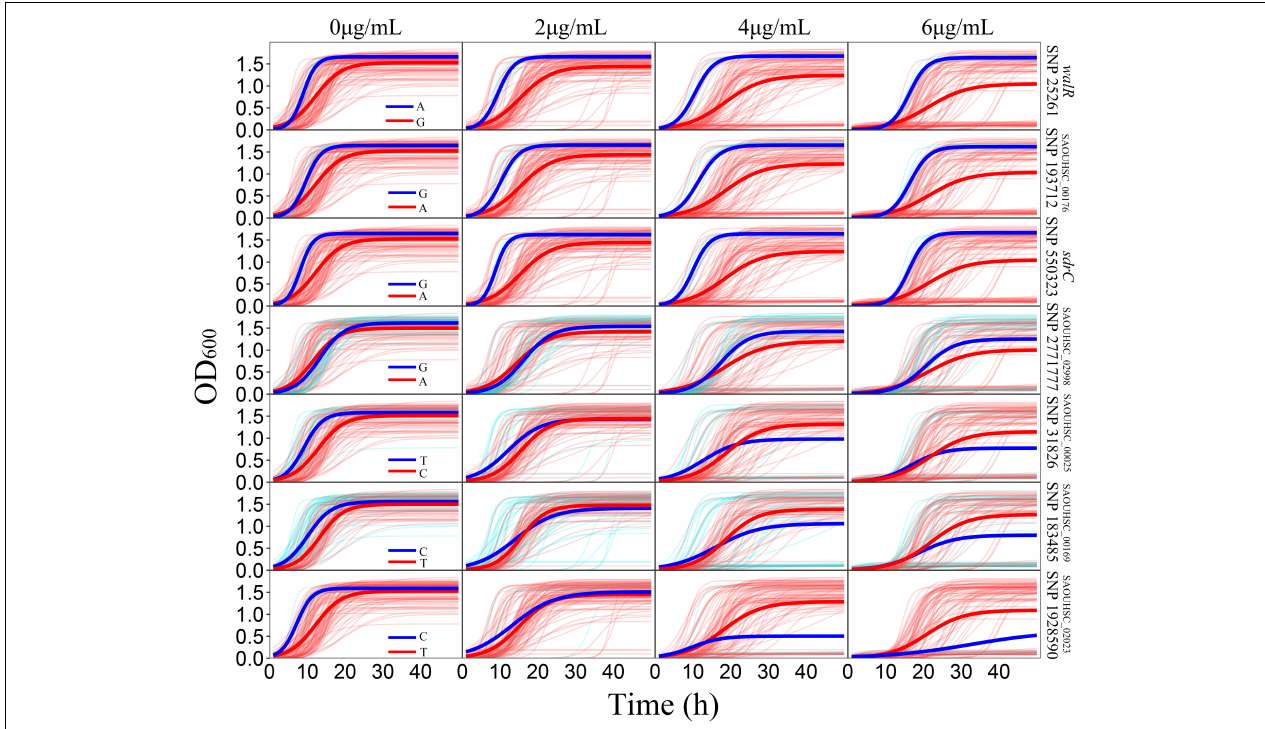
FIGURE 4 | Growth variations of significant SNPs. For each SNP, strains were divided into two groups according to their genotypes. The thick red and blue lines represent the average growth curves of the two genotypes, while the thin lines in the background represent the individual growth curves.